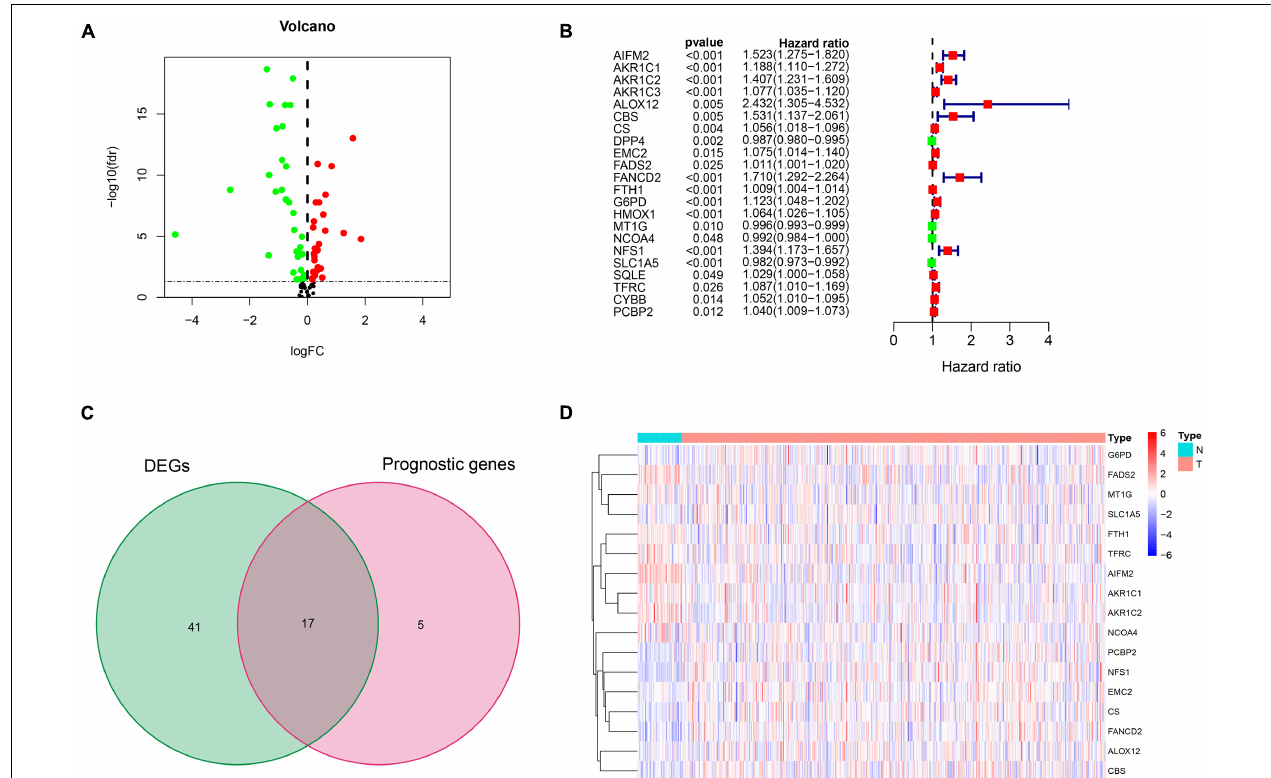
FIGURE 2 | Initial screening of potential prognostic ferroptosis-related genes in The Cancer Genome Atlas (TCGA) cohort. (A) Volcano plot of differential expression of ferroptosis-related genes between prostate cancer (PCa) tissues and normal tissues. (B) Twenty-two ferroptosis-related genes associated with biochemical recurrence (BCR) of PCa patients through univariate Cox regression analysis. (C) Identification of 17 prognostic genes by intersection. (D) Heat map of the expression of 17 prognostic genes between PCa and normal